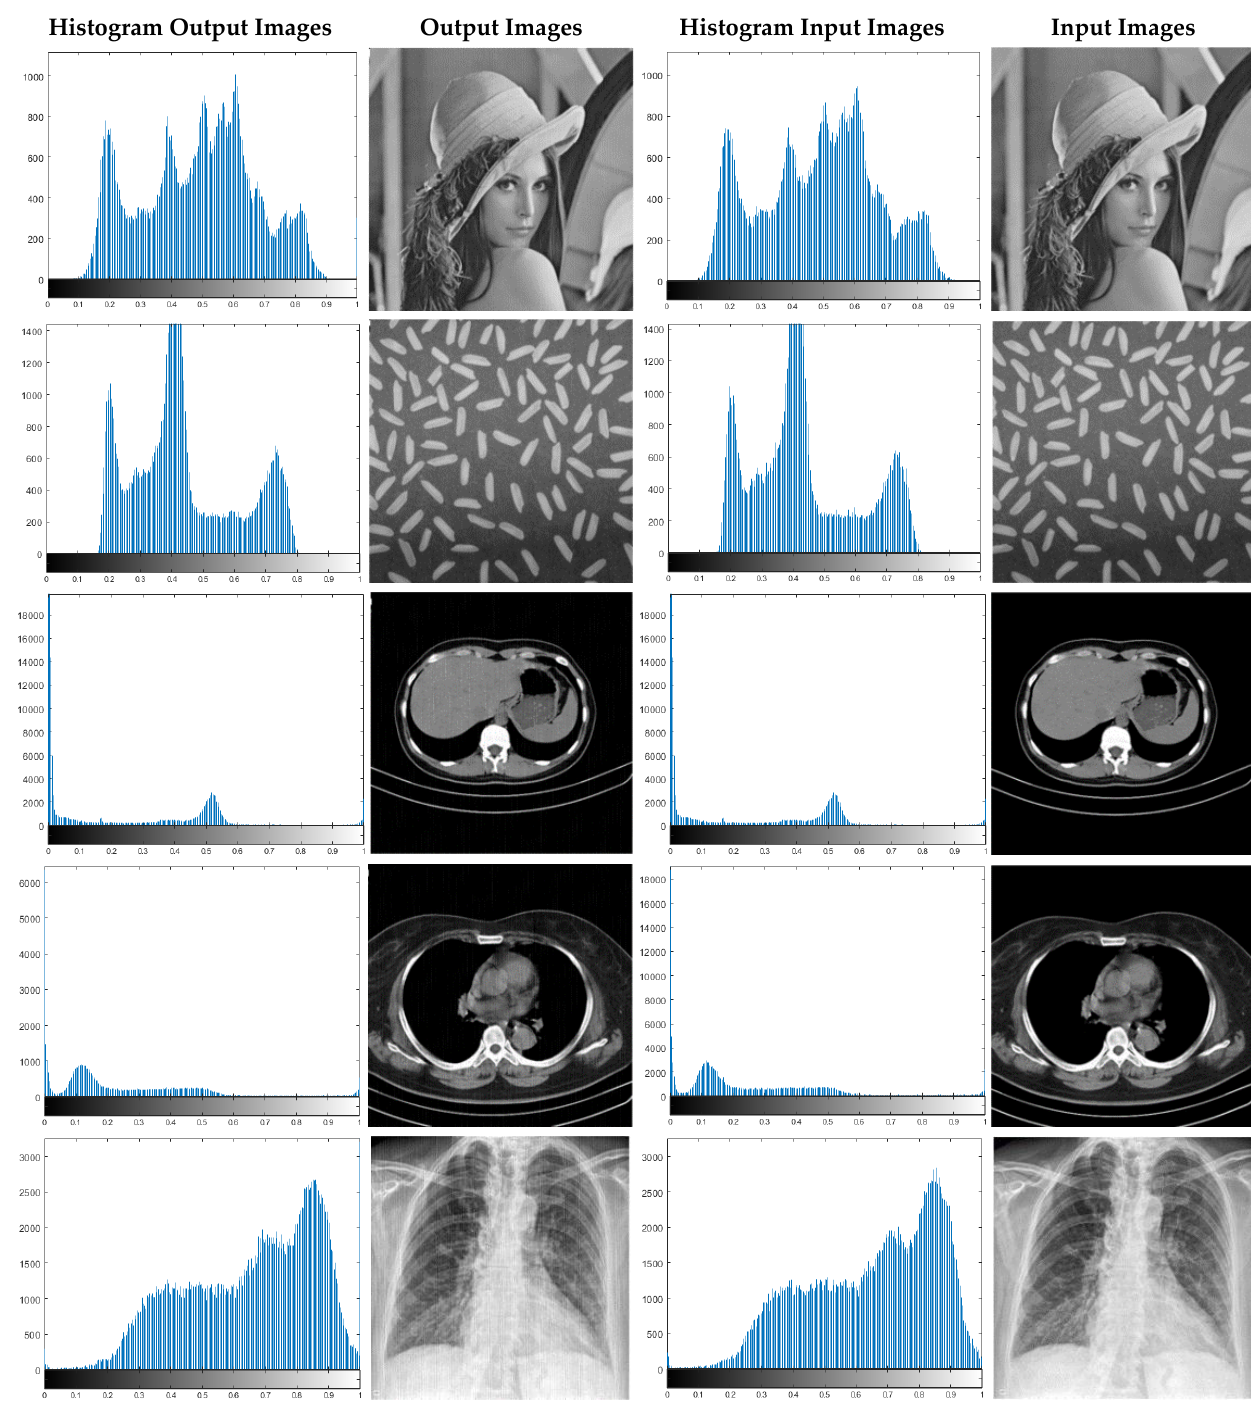
Figure 17. Displayed histograms for various images encrypted using the proposed method.